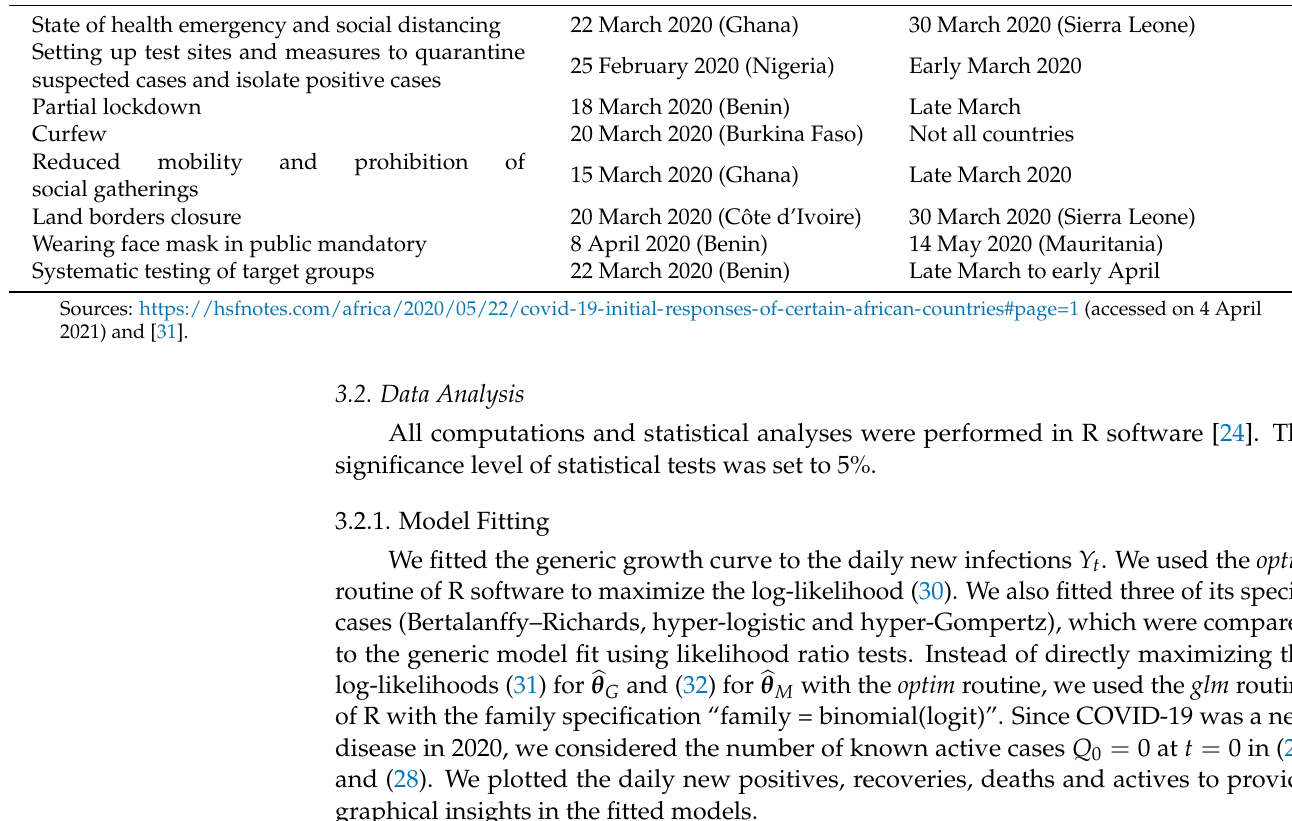
Table 2. Main sequence of public health and movement restriction measures taken by West African governments during the first phase of the COVID-19 pandemic (until 31 August 2020). Main Interventions First Introduction